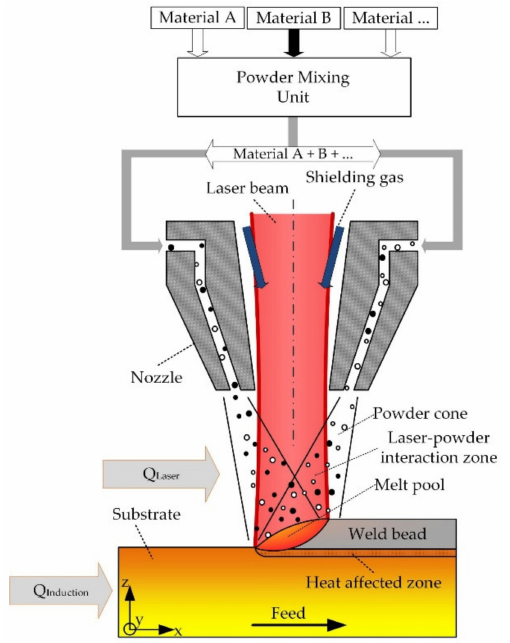
Figure 1. Illustration of the multi-material LMD process with additional inductive substrate heating, reproduced and adapted with permission from